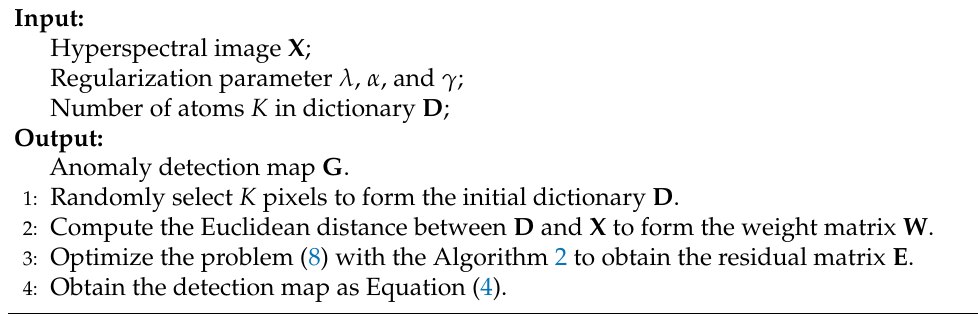
Figure 1. The flowchart of the proposed LCLRR method. Algorithm 1 HAD algorithm based on LCLRR